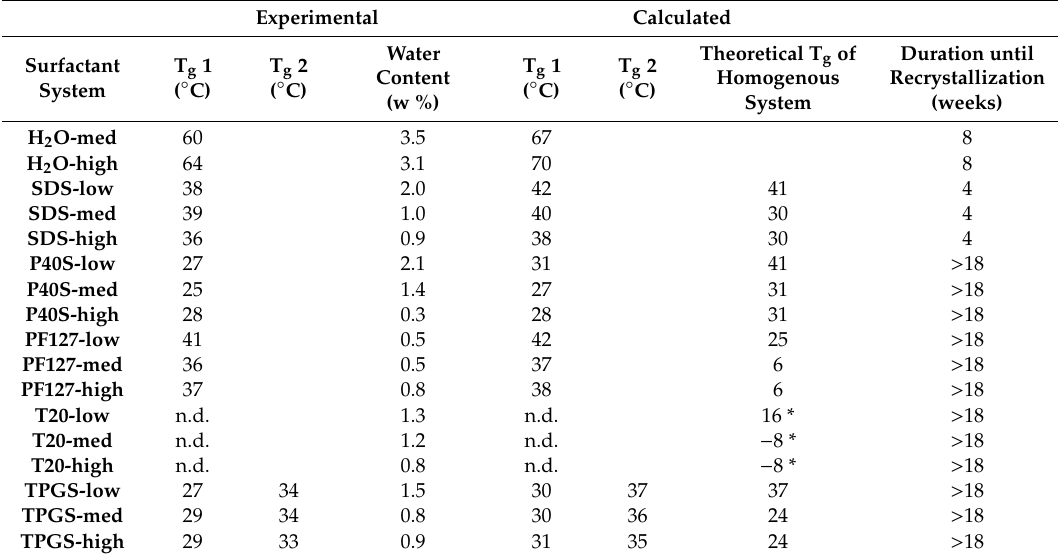
Table 2. Experimentally determined T g s for naproxen-lysine (NAP-LYS) co-amorphous systems and water content of the systems. Re-calculated T g for the systems without water, theoretical T g for a homogenous system and storage stability as duration until first recrystallization. Calculated values for Tween 20 systems marked with * must be regarded as estimates. n.d. = not detectable.